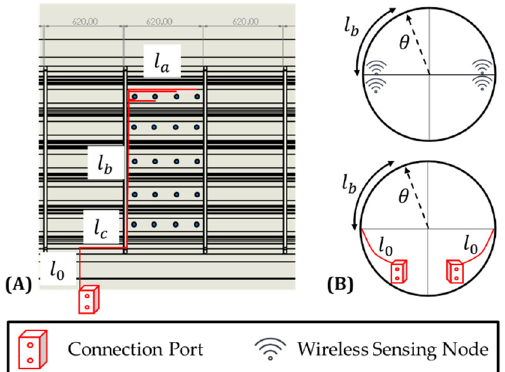
Figure 5. Illustration of the cable routing for the aircraft fuselage ( A ) side view and ( B ) cross-se view, indicating the location of the connection ports and the WSN nodes.